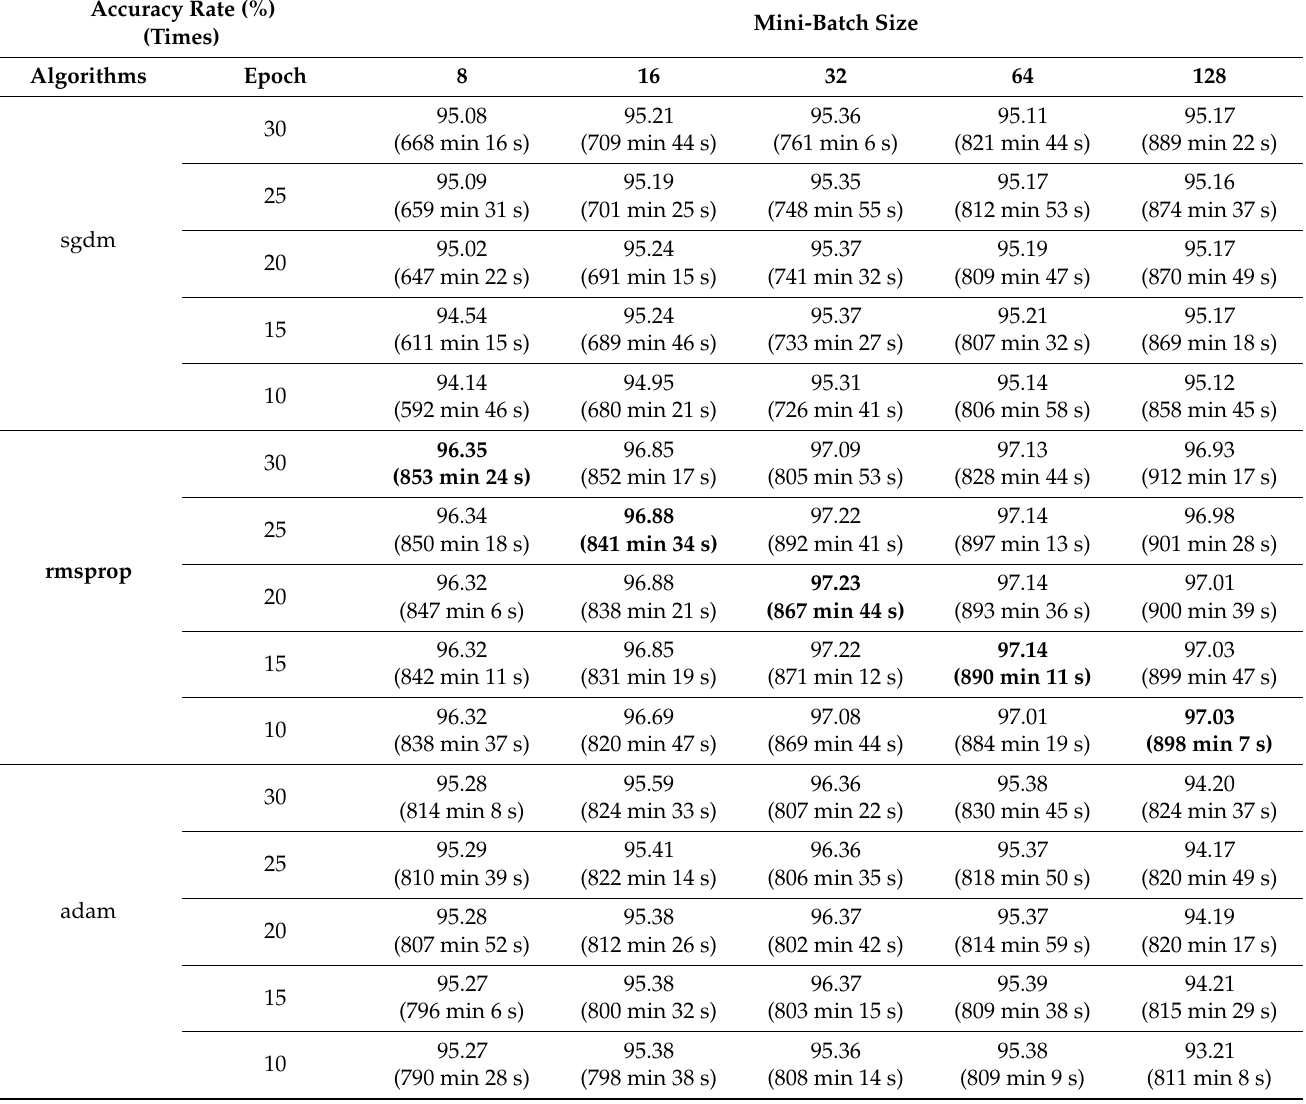
Table 3. Comparison of network optimizers